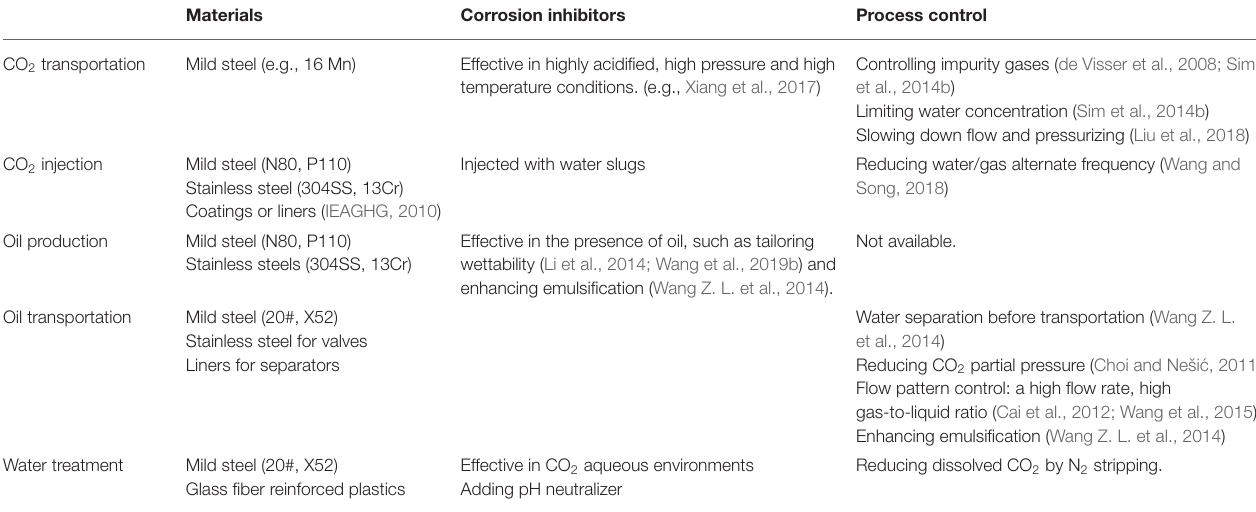
TABLE 2 | Corrosion control strategies in CCS-EOR systems.